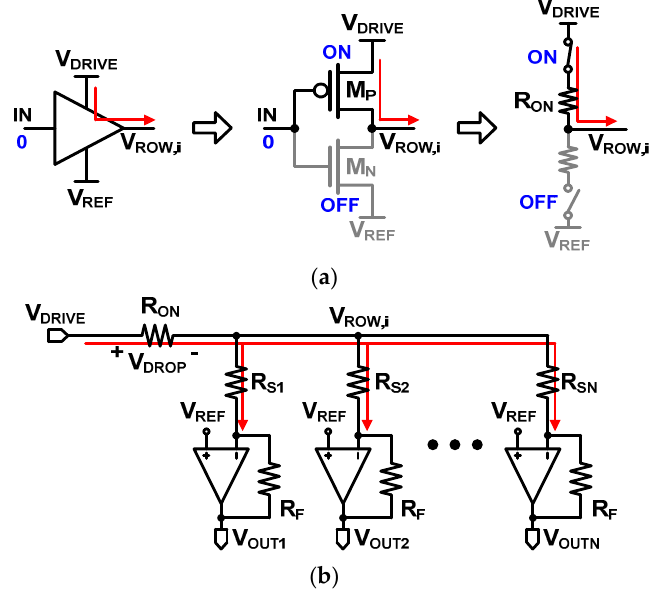
Figure 4. ( a ) Equivalent switch model of a digital buffer; and ( b ) equivalent circuit model of a resistive sensor array with the Type I row driver.